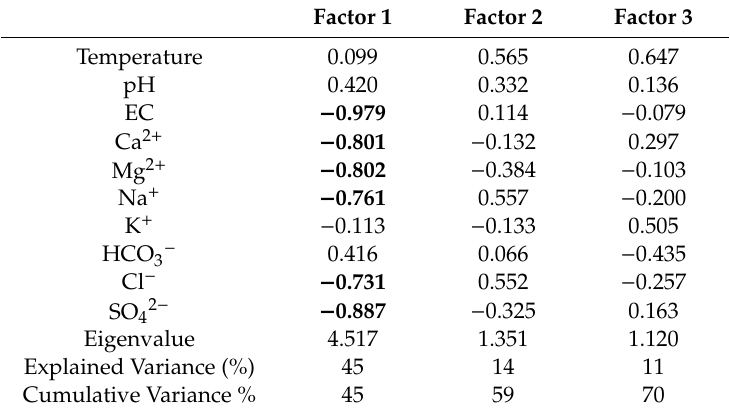
Table 3. Factor analysis results. Factor loadings and explained variance. High loadings ( | Loading | > 0.7) are in